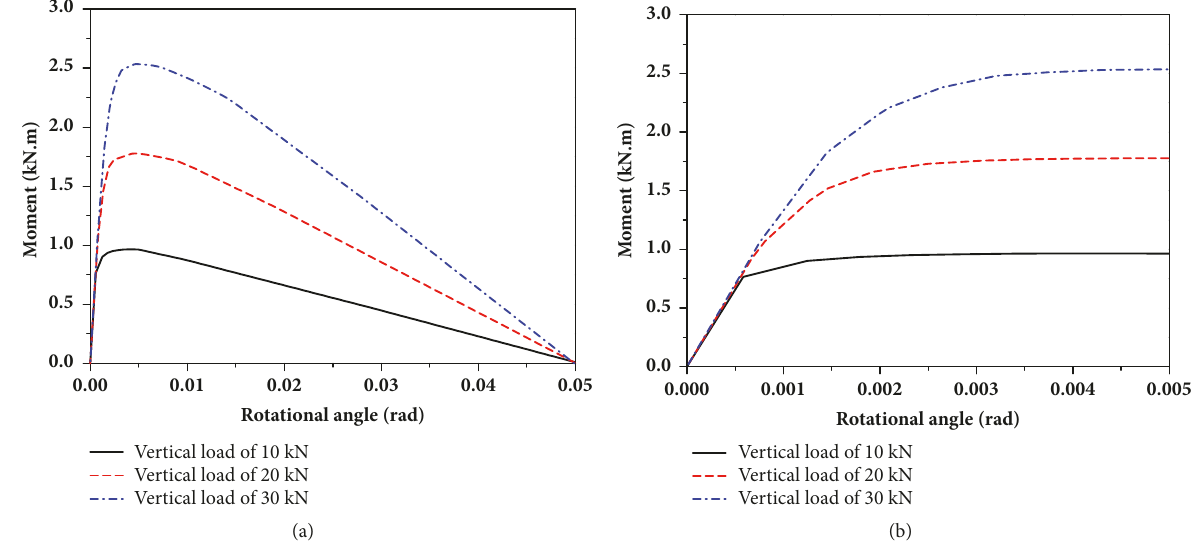
Figure 6: Moment-rotation curves under different vertical load: (a) global view; (b) local view.